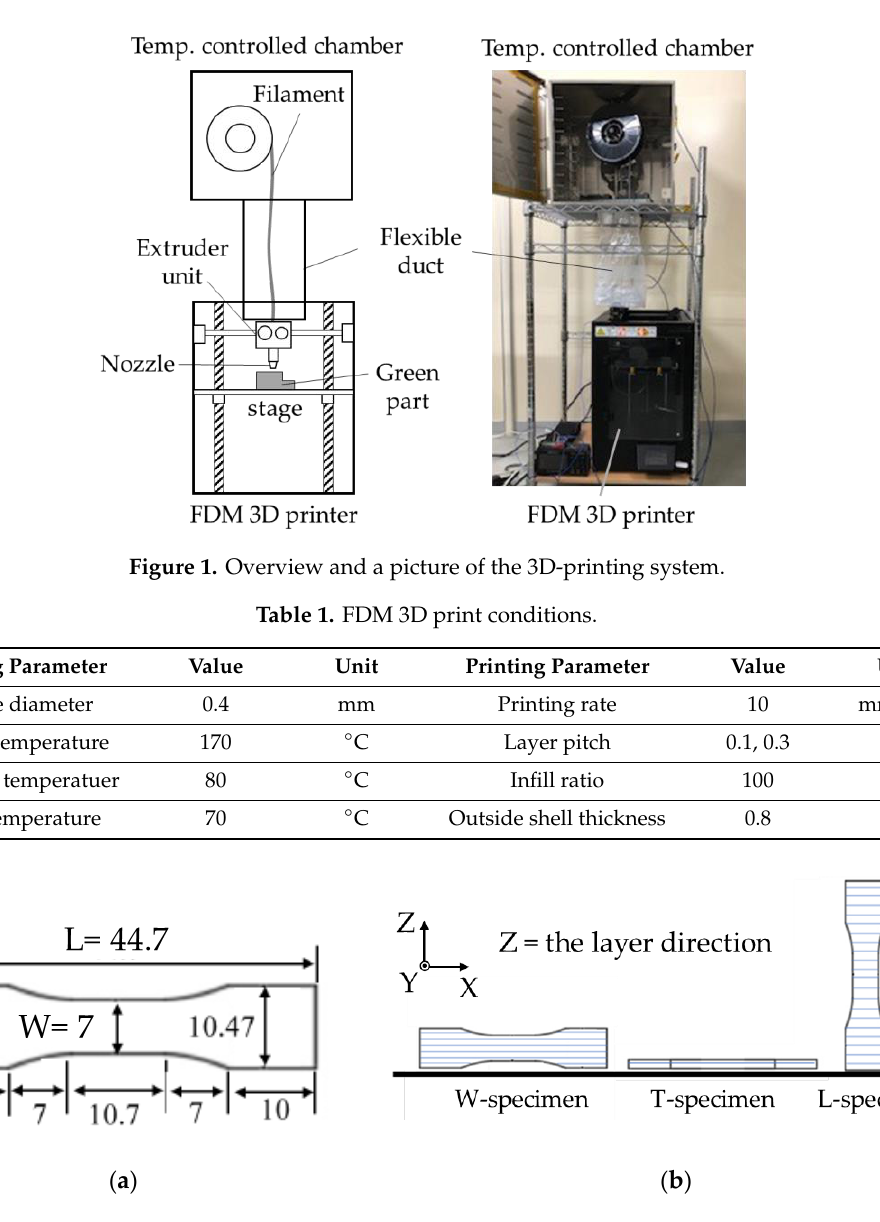
Figure 2. ( a ) Dimension of a specimen. ( b ) Layer directions of various specimens and the coordinate axes.